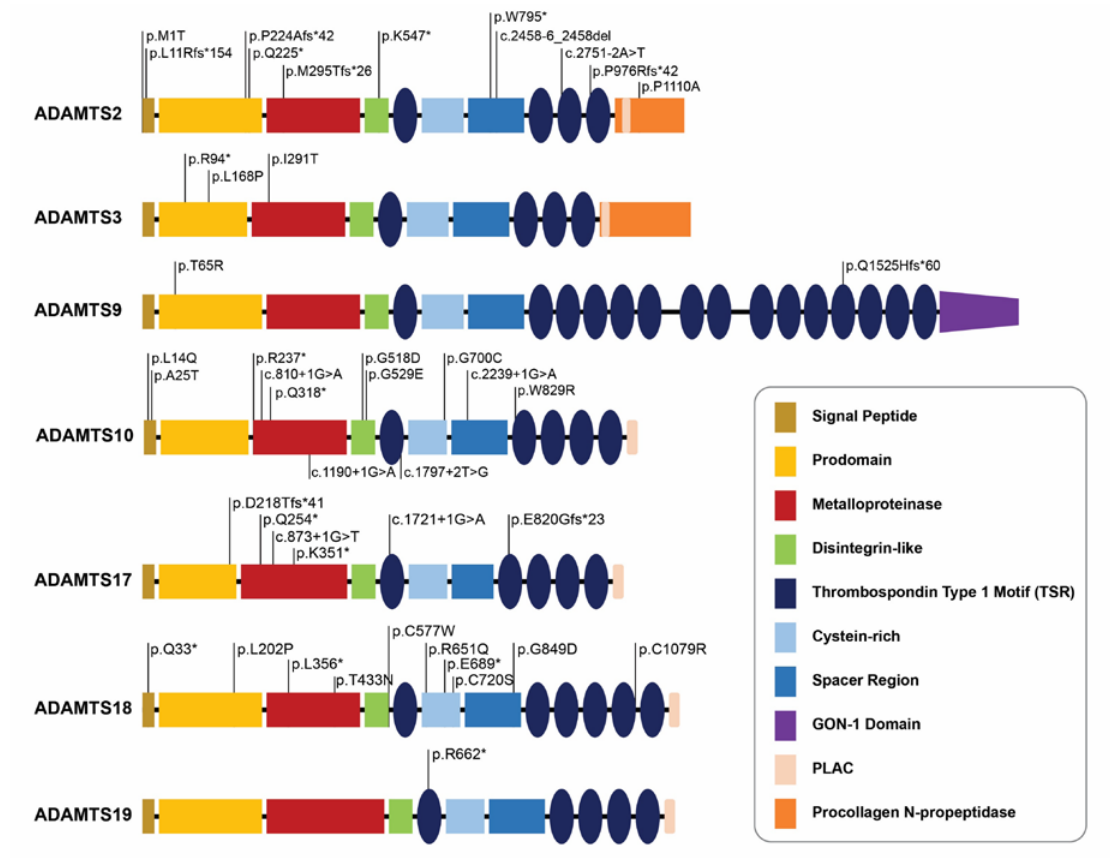
Figure 3. Comparative analysis of pathogenic mutation loci across ADAMTS genes with strong relationship with specific Mendelian disorders. Positional annotations of pathogenic mutations in ADAMTS genes by protein functional domains indicate the wide distribution of mutations and absence of hot spots. “*” (asterisk) indicates a translation termination codon.